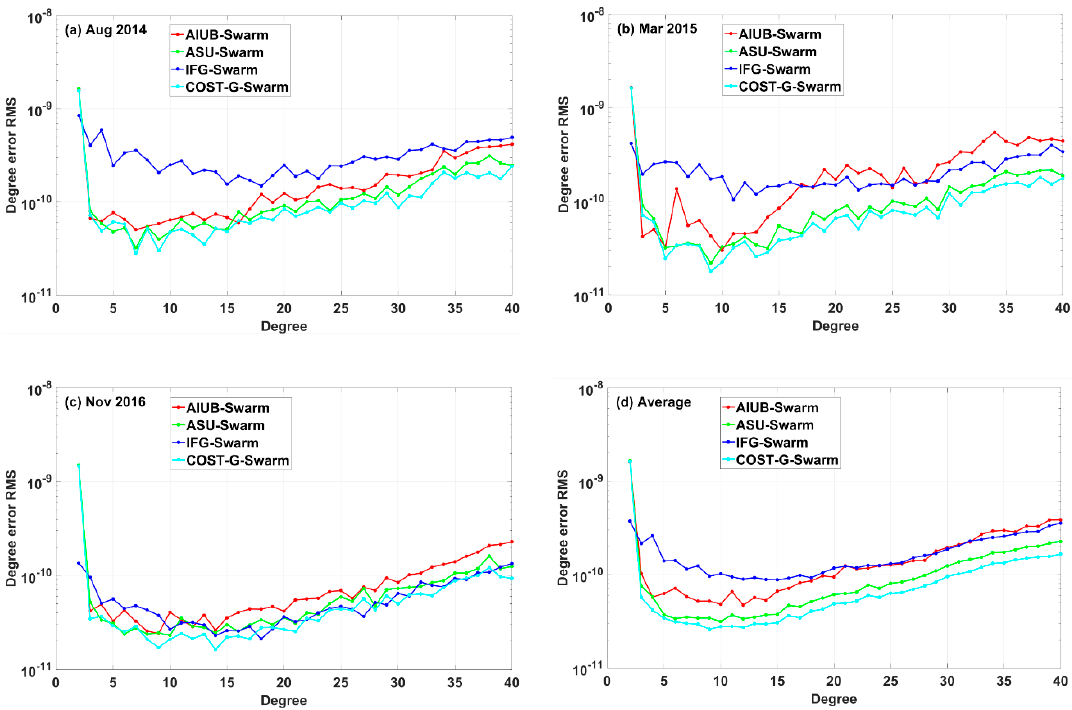
Figure 4. Degree-error root mean square (RMS) of the residual values of spherical harmonic (SH) coe ffi cients of Swarm monthly gravity field relative to the GRACE model.